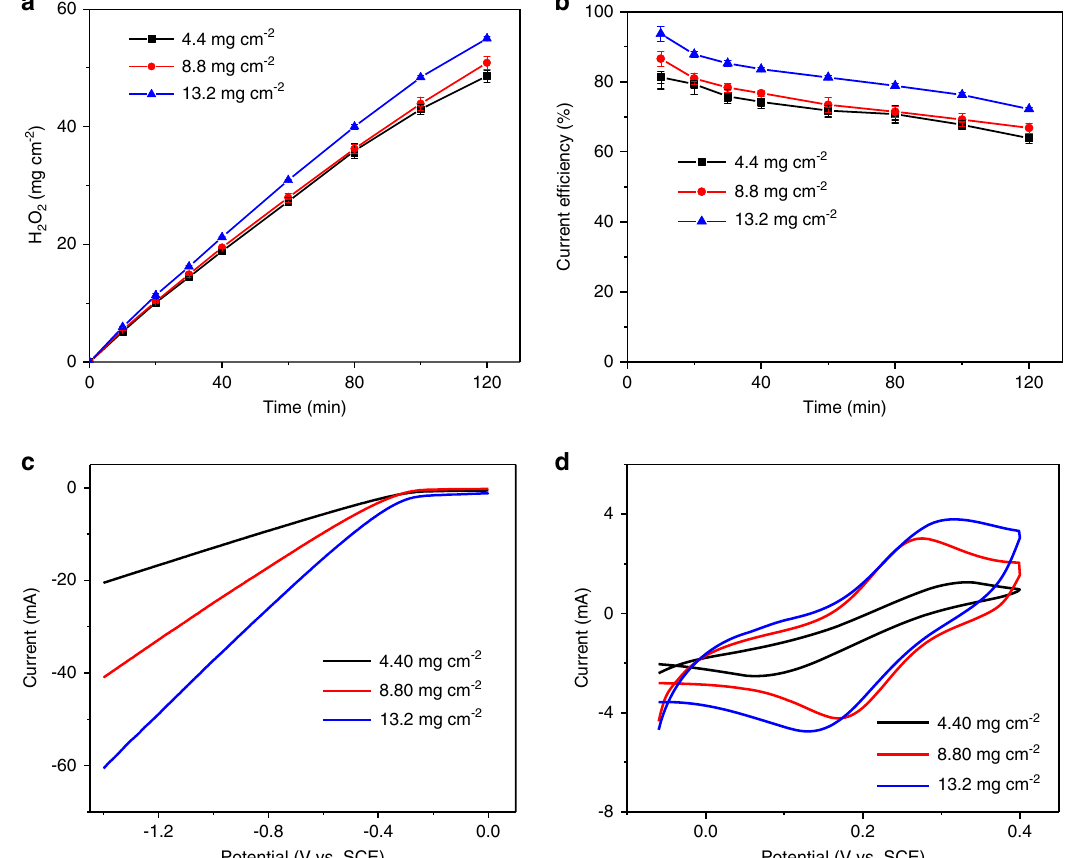
Fig. 3 Effect of catalyst loading on the ORR performance. The effect of catalyst loading on a the yields of H 2 O 2 , b current ef fi ciency, c LSV, and d CV in 1 M KCl containing 10 mM K 4 [Fe(CN) 6 ]. The error bars in a , b represent the standard deviation of three independent samples. Source data are provided as a Source Data fi